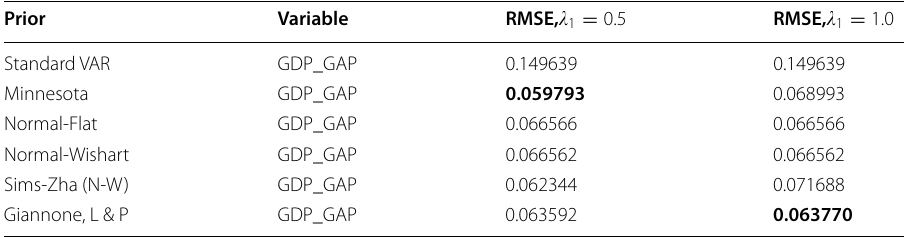
Table 1 Forecasting using Bayesian estimation prior types 2019:1–2019:12. Source : Authors’